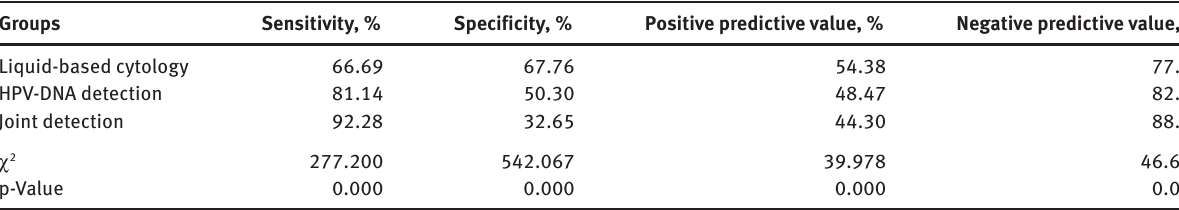
Table 1: Detection efficiency of liquid-based cytology and HPV-DNA in patients under 30 years of age.